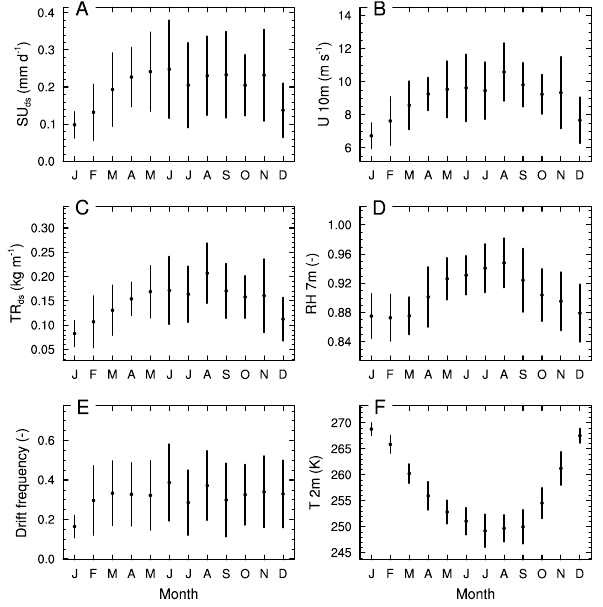
Fig. 9. 15-yr (1993–2007) monthly means (dots) and variability (the doubled standard deviation on the error bars) of SU ds (A) , TR ds (C) , snowdrift frequency (E) and the 10m wind speed (B) , 7m relative humidity (D) and 2m temperature (F)